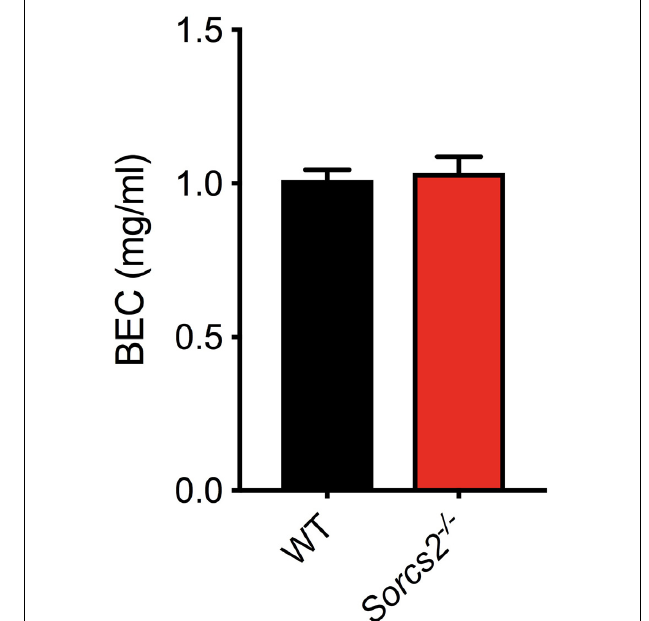
FIGURE 5 | Sorcs2 − / − mice metabolize ethanol normally. Blood ethanol concentrations BECs determined in WT and SorCS2 − / − mice 20 min after a 2.0 g/kg ethanol i.p. injection. There were no significant differences in ethanol levels between the strains ( P = 0.79) ( n = 4 for WT and n = 9 for SorCS2 − / −